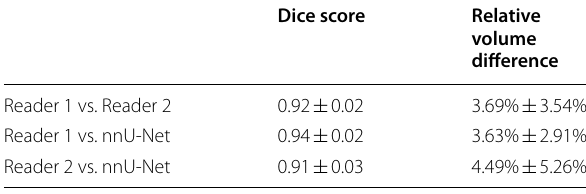
The table provides the mean Dice scores and the mean relative volume difference